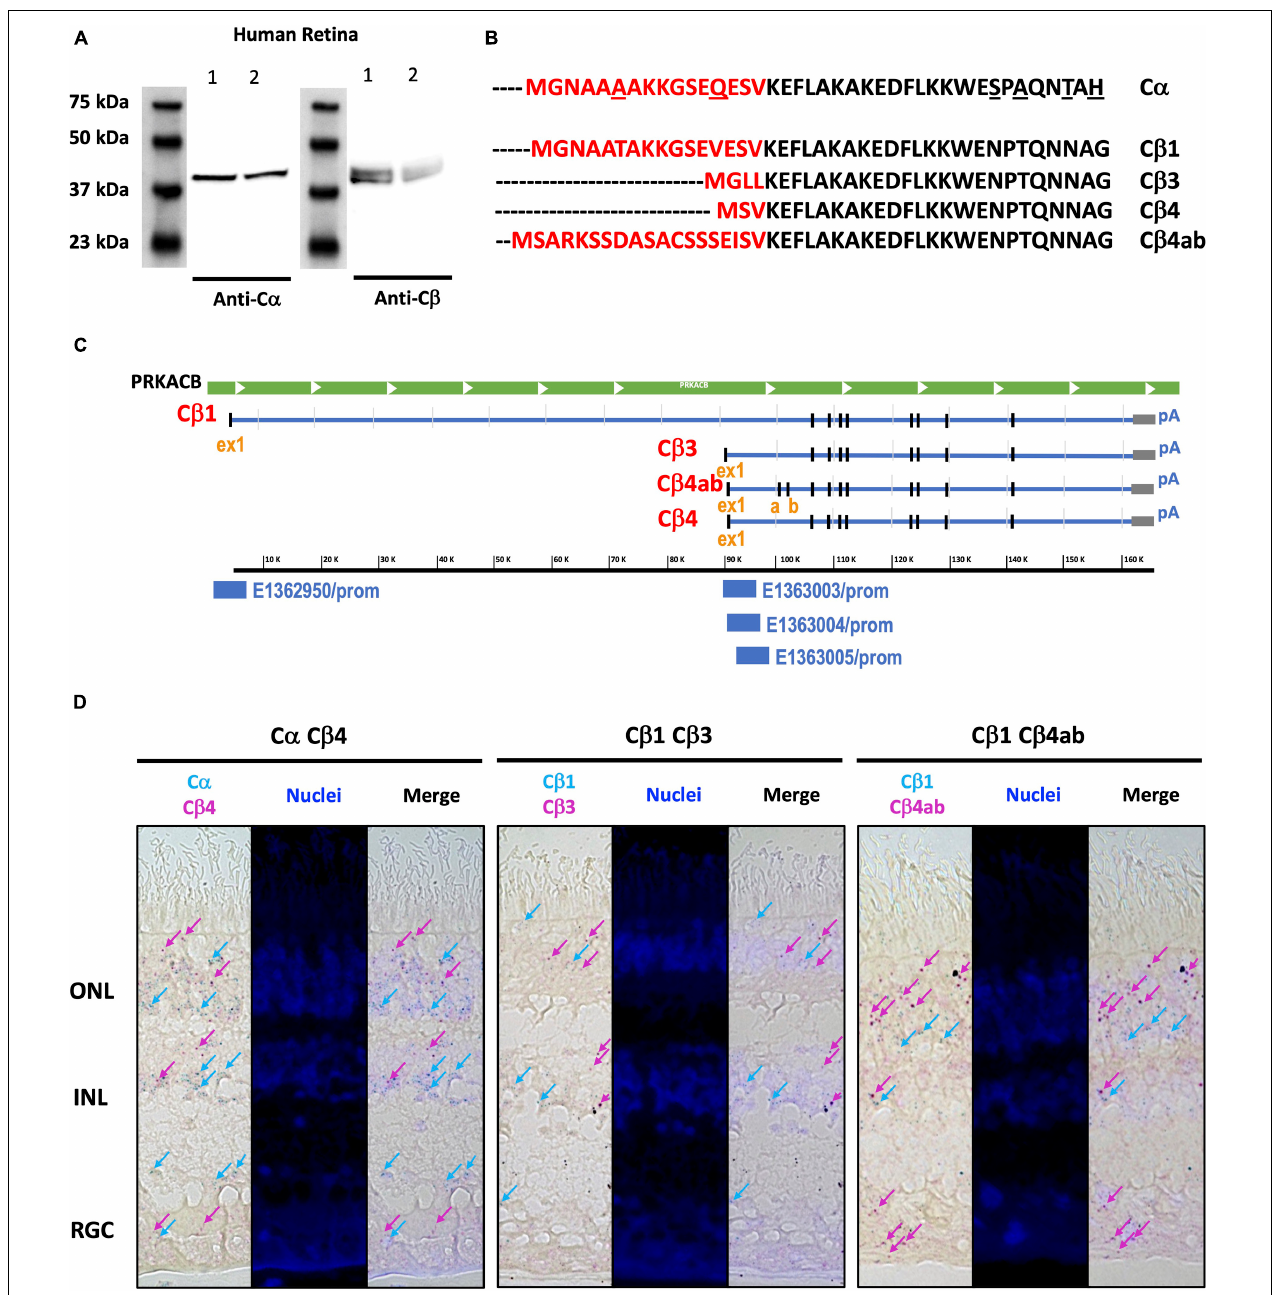
FIGURE 7 | Similar C α and C β proteins are present but multiple C β splice variants show variable expression across the human retina. (A) Anti-C α antibodies recognized a ∼ 39 kDa band, and anti-C β antibodies recognized two bands at ∼ 39 and ∼ 42 kDa bands, in Western blots from two samples (Cohen and Blazynski, 1990; Cohen et al., 1992) of human retina tissue extracts. (B) Protein sequence alignment of C α and C β splice variants C β 1, C β 3, C β 4, and C β 4ab, and (C) Corresponding RNA sequence alignments of C β isoforms, with unique promoter sequences identified for each variant explored. ex1, exon 1; a, b, exon a, exon b. (D) BaseScope Duplex assay results show C α , C β 1, C β 3, C β 4, and C β 4ab expression in photoreceptors in the outer nuclear layer (ONL) and interneurons in the inner nuclear layer (INL). C β 4 and C β 4ab were also expressed in the retinal ganglion cell layer (RGC). Expression of C α and C β 1 highlighted by blue arrows, and expression of C β 3, C β 4, and C β 4ab highlighted by magenta